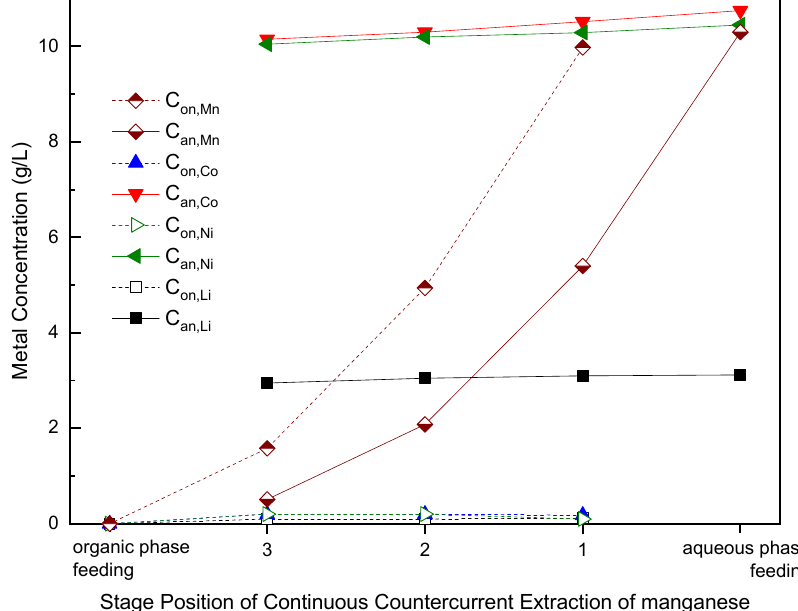
Figure 7. Metals concentrations in conventional continuous-countercurrent-extraction of manganese. P-204/kerosene—1:4 v/v ; saponification: 60%; O/A—1:1; retention time in each tank—5 min.